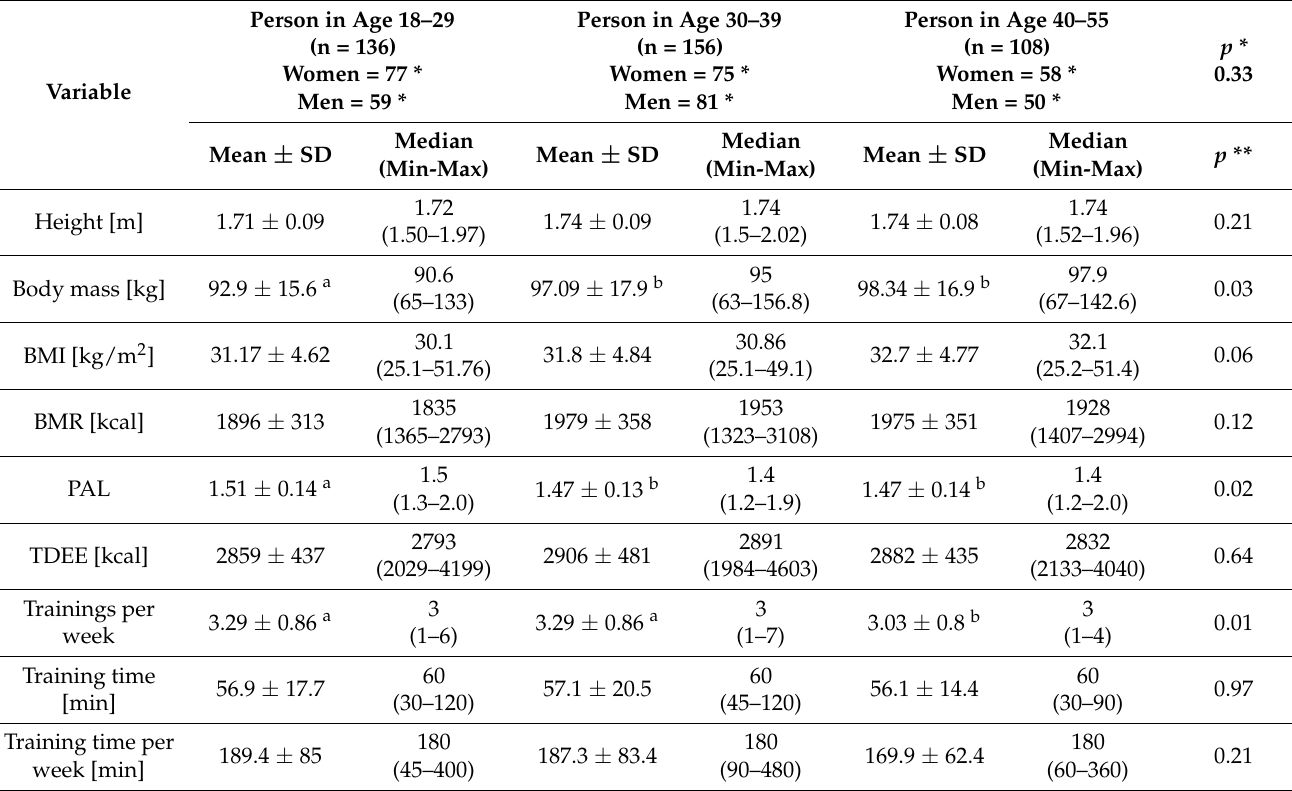
Table 4. Characteristics of participants at the beginning of the intervention by 3 age